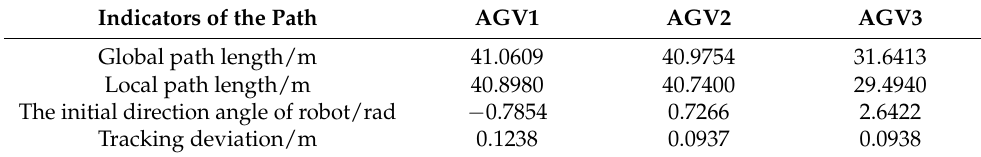
Table 7. Multi-robot path planning results in a known static